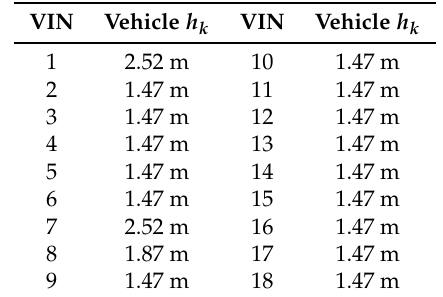
Table 8. Vehicle data.